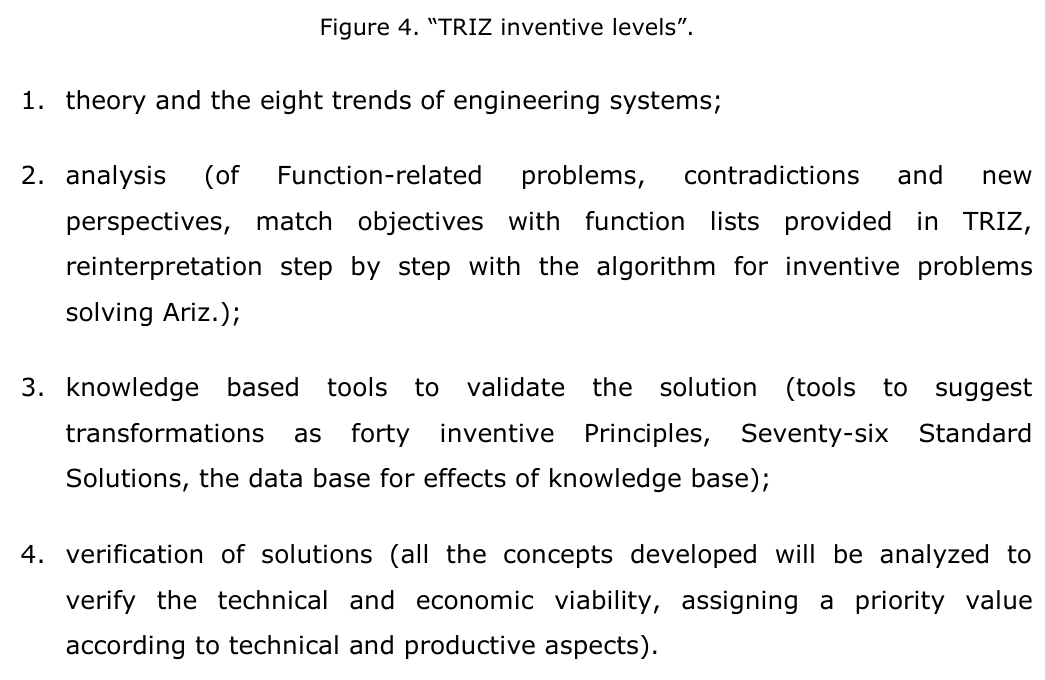
Figure 4. “TRIZ inventive